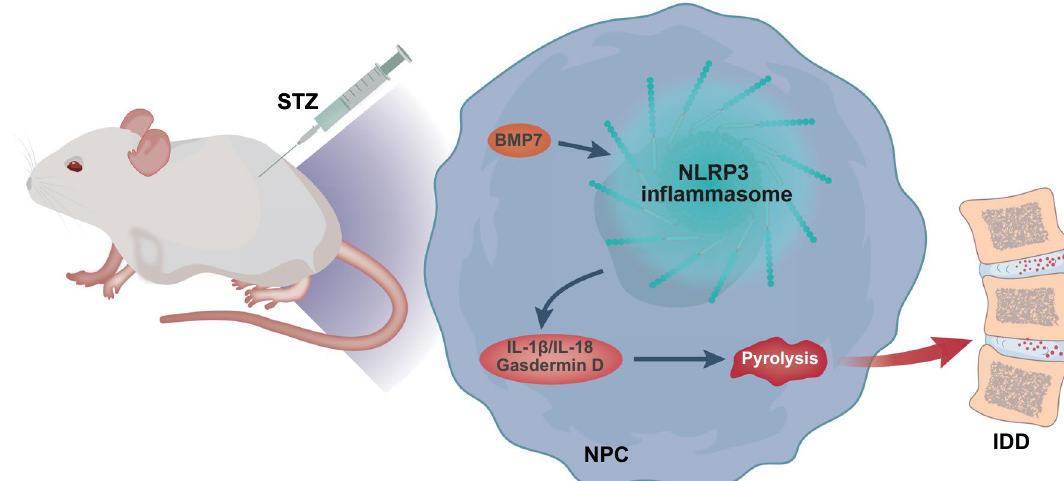
Fig. 8 Molecular mechanism of BMP7 involved in the IDD of T1DM rats. BMP7 inhibits NPC pyroptosis and NLRP3 inflammasome activity to ameliorate IDD in